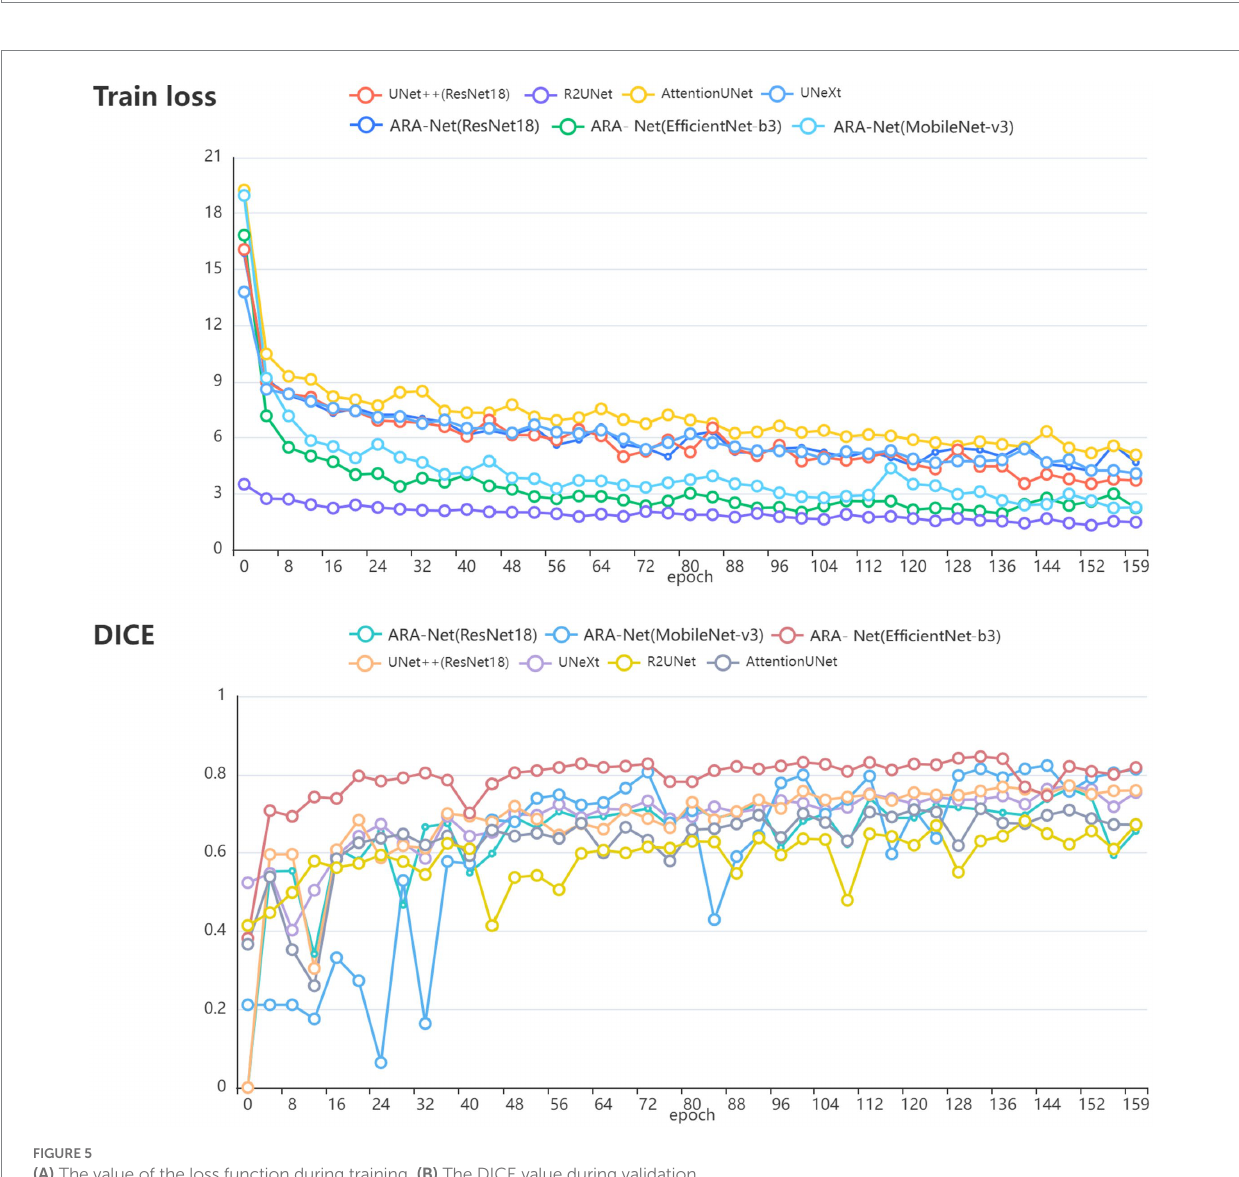
segmentation techniques allow for efficient extraction and representation of image features, reducing the need for human intervention.